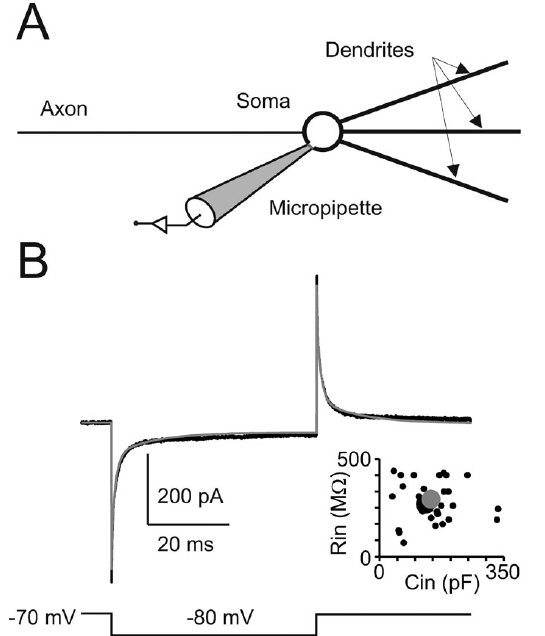
Figure 1. Passive Golgi cell properties . ( A ) Schematics of the minimal model built to reproduce cerebellar Golgi cell electroresponsiveness. The model has a spherical soma and processes representing the dendrites and axon. The soma is connected to a micropipette to simulate realistic recording conditions. ( B ) The recording (black trace) shows a current transient elicited in a Golgi cell by a 50-ms voltage step from (cid:1) 70 to (cid:1) 80mV. The model (gray trace) faithfully matches the response. The plot shows the relationship between input resistance (R in ) and input capacitance (C in ) in 39 Golgi cells (black circles, the larger one corresponding to the trace shown on top). The model prediction (large gray dot) falls in the middle of the experimental data distribution (p > 0.8, t-test)